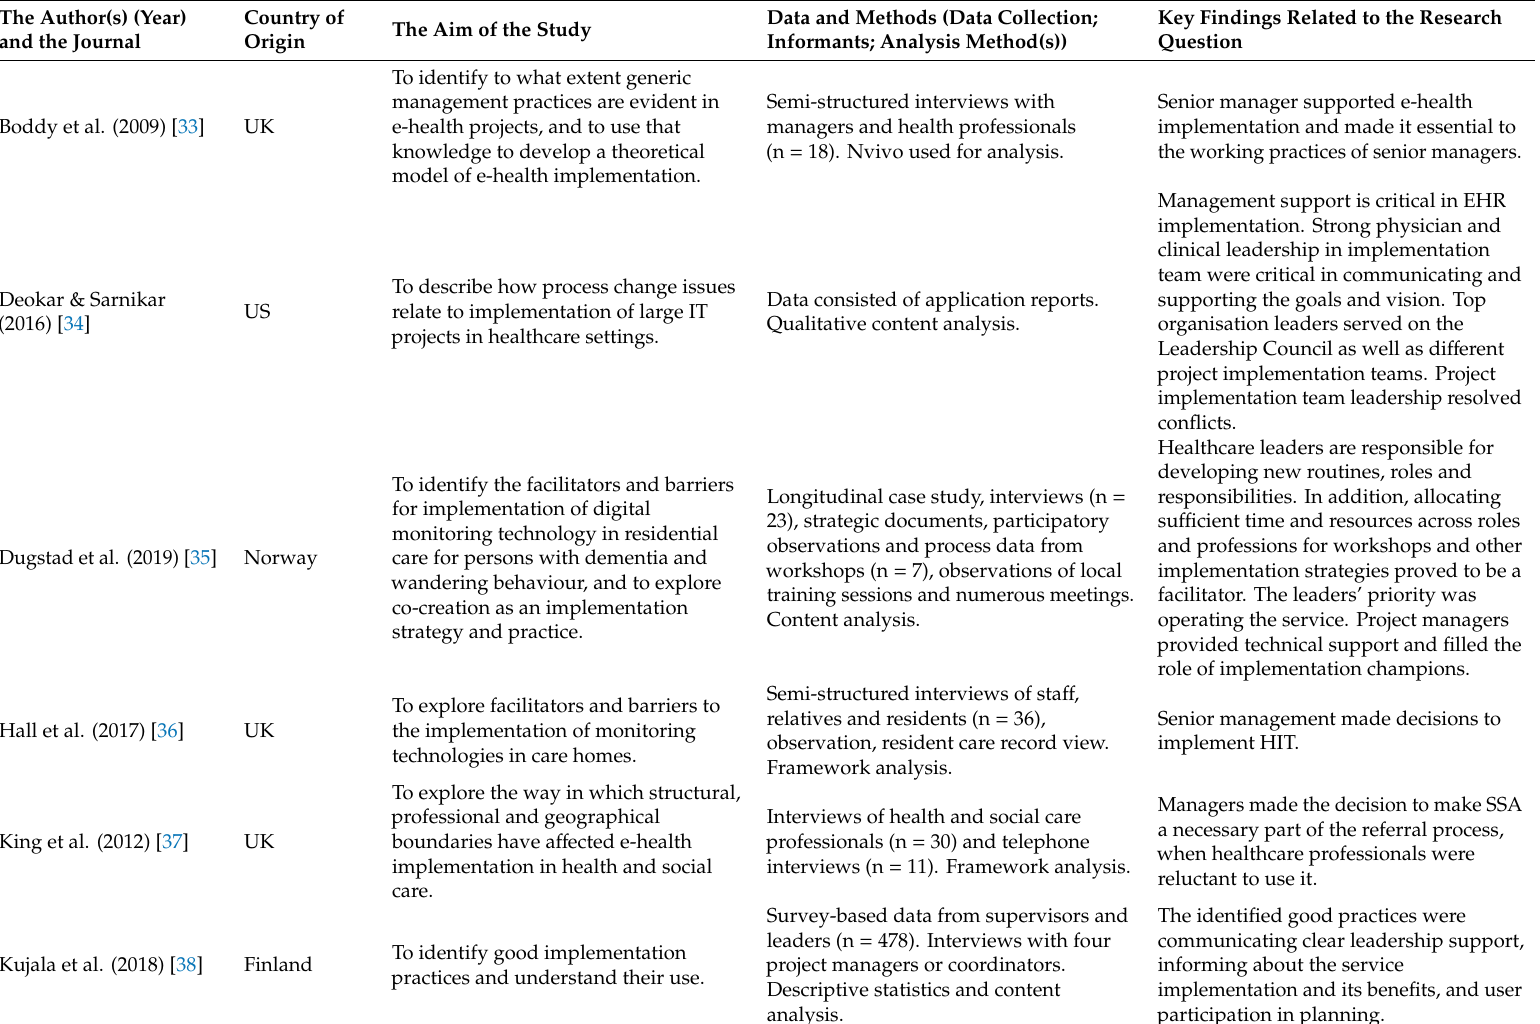
Table 2. Data extraction of the included